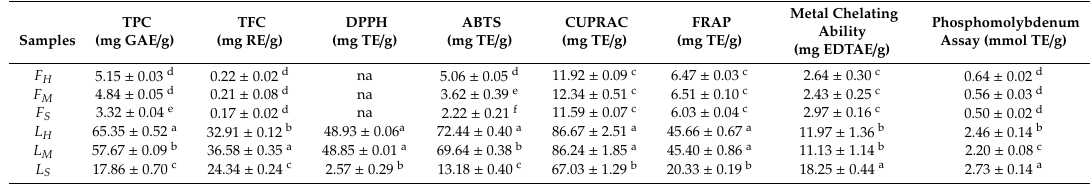
Table 6. TPC, TFC, and antioxidant assays for leaf and fruit Elaeagnus angustifolia extracts.